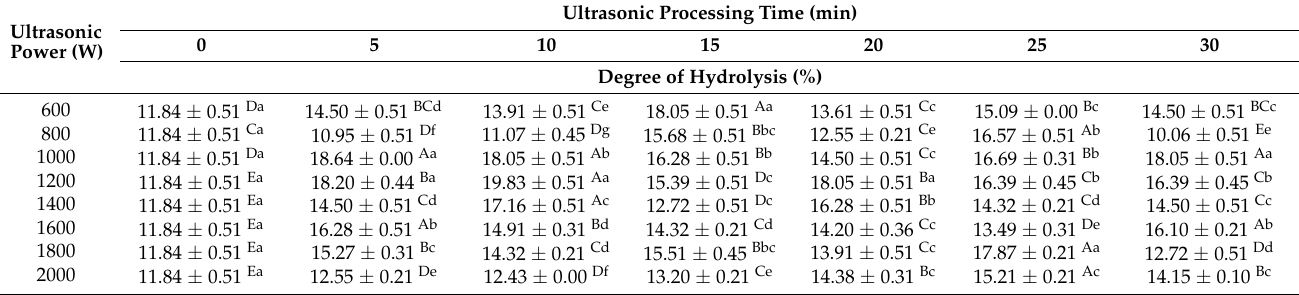
Data are the averages of three replications ± standard deviation. A–G: Different uppercase letters mean significant difference in comparisons between ultrasonic processing time (0, 5, 10, 15, 20, 25, and 30 min) for each power at p < 0.05. a–g: Different lowercase letters mean significant differences between ultrasonic power (600, 800, 1000, 1200, 1400, 1600, 1800, and 2000 W) for each processing time at p <